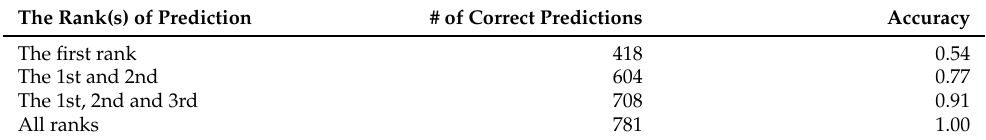
Table 3. The number of the correctly predicted results and the accuracy of the predictions in the ranks of prediction. For example, ”the 1st and 2nd” means the predicted results includes the actual throwing technique in the first and the second topmost predicted results. The accuracy is derived from the number of correct predictions by dividing the total number of the test dataset (i.e., 781). The Rank(s) of Prediction # of Correct Predictions Accuracy The first rank